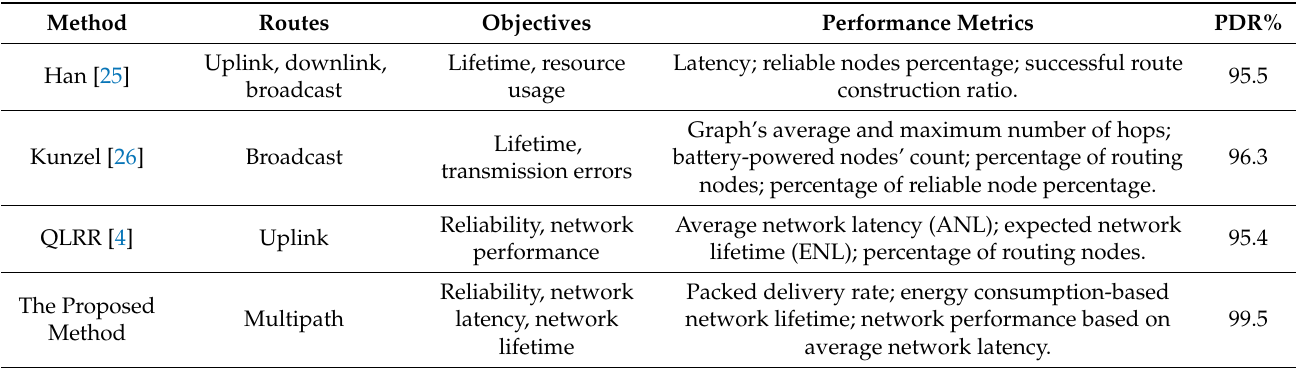
Table 4. Performance comparison of MPR with